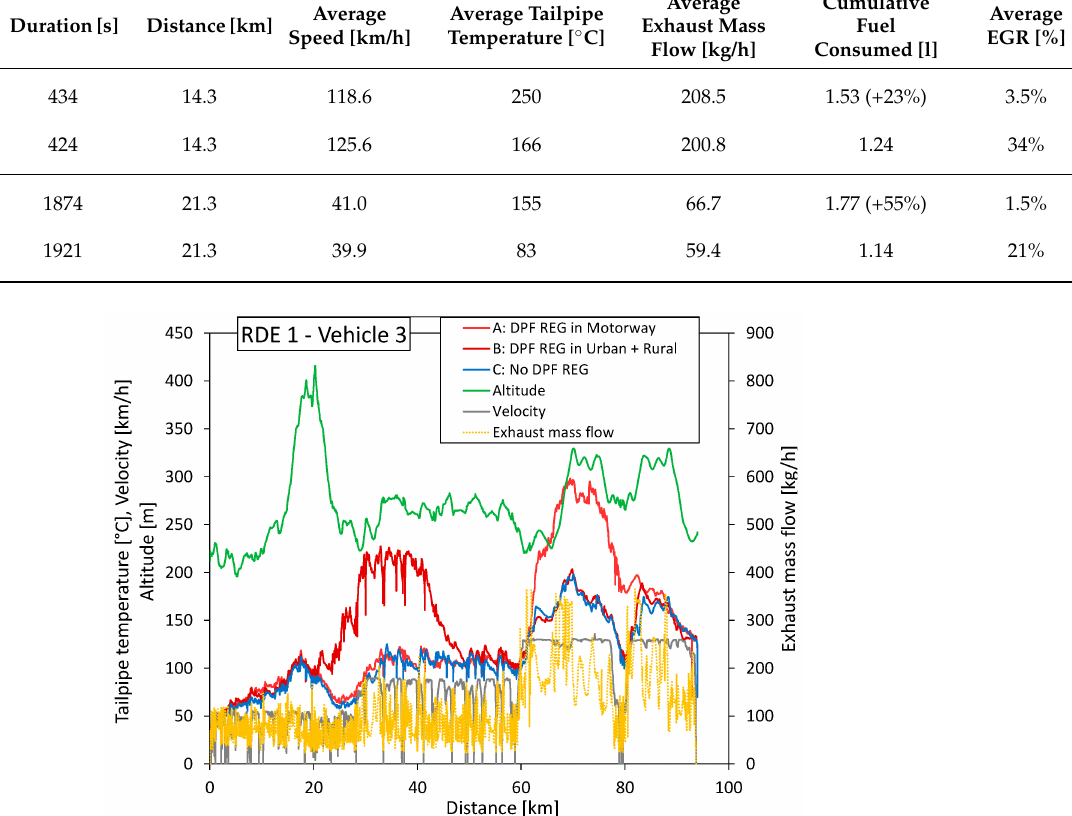
Figure 8. Tailpipe temperature during the DPF regeneration events of Vehicle 3 in different repetitions of the RDE 1